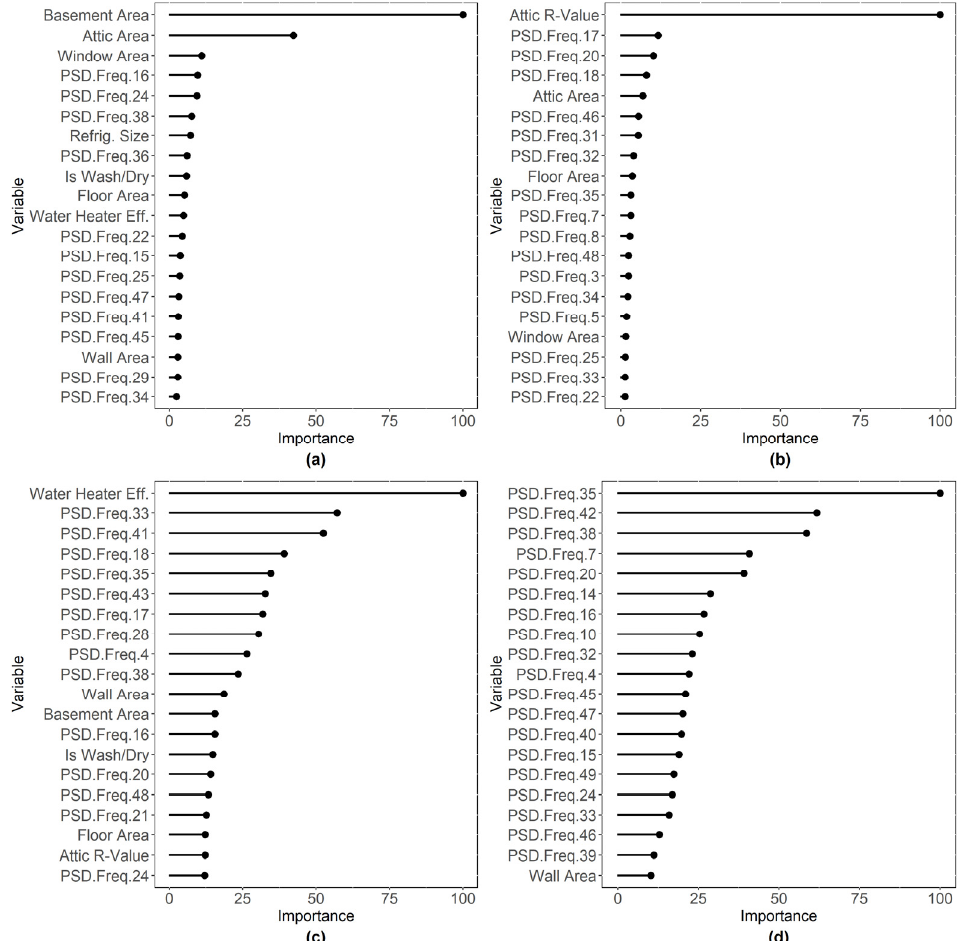
Figure 3. Variable importance plots including thermostat-derived information for the ( a ) attic R-value model, ( b ) wall R-value model, ( c ) furnace efficiency model using the natural gas dataset, and ( d ) AC SEER model using the electric dataset.